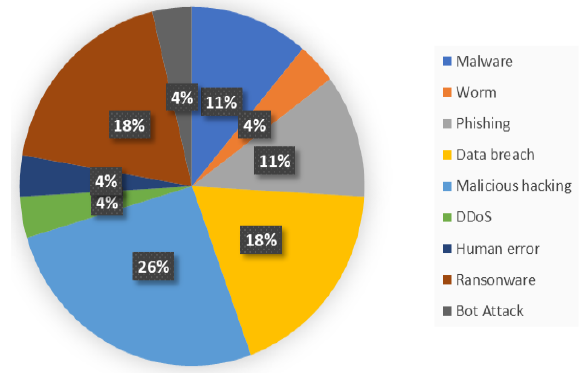
Figure 2. Cyber-Attacks by